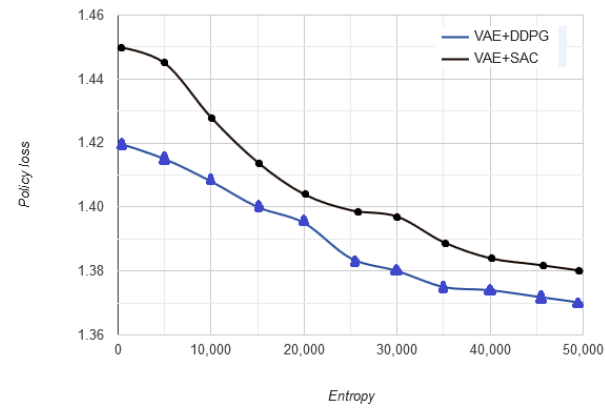
Figure 11. Policy loss vs. no. of